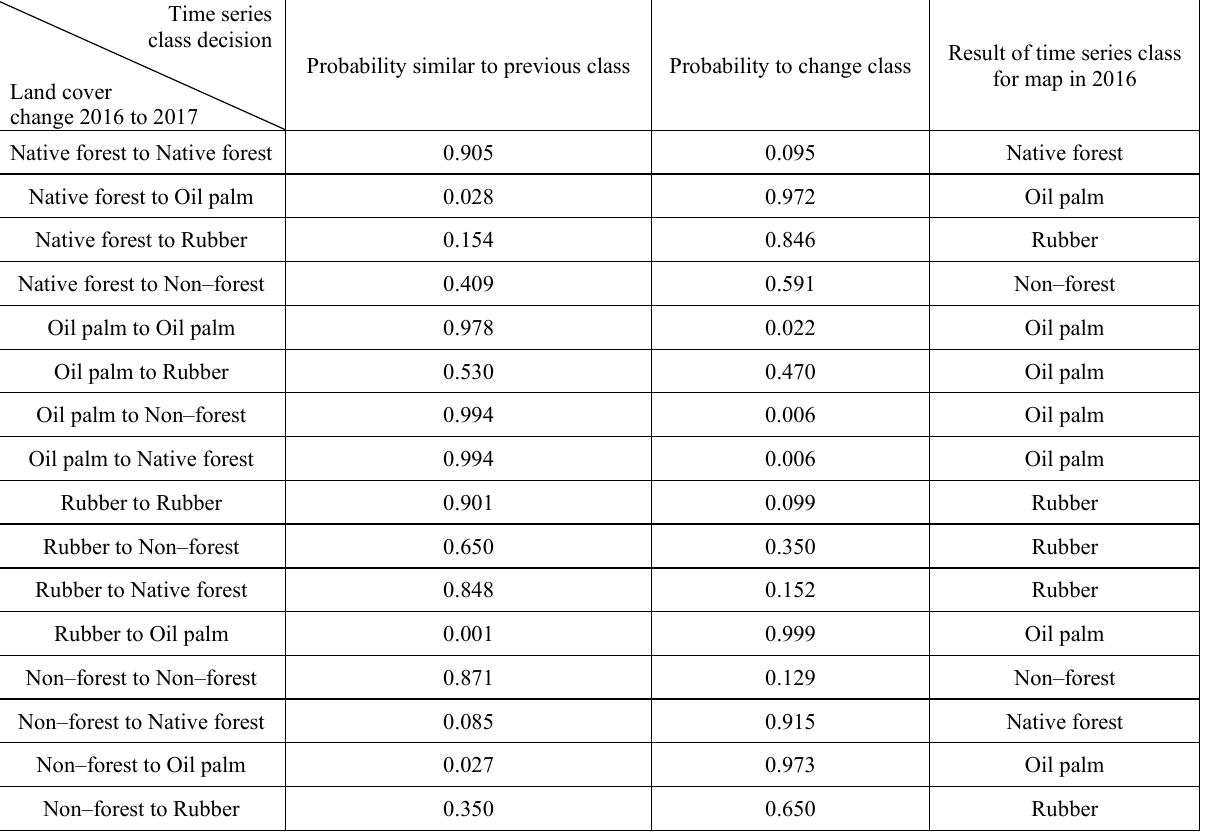
Table 4. Decision-making result for time series classification for 2016 to 2017. Images of individual year land cover classification, oil palm and Classification accuracy for the final time series land cover map in 2017 has an overall accuracy of 90%. Detailed accuracy for series classification maps from 2015 to 2017 are shown in Figure each land cover class is shown in Table 3.